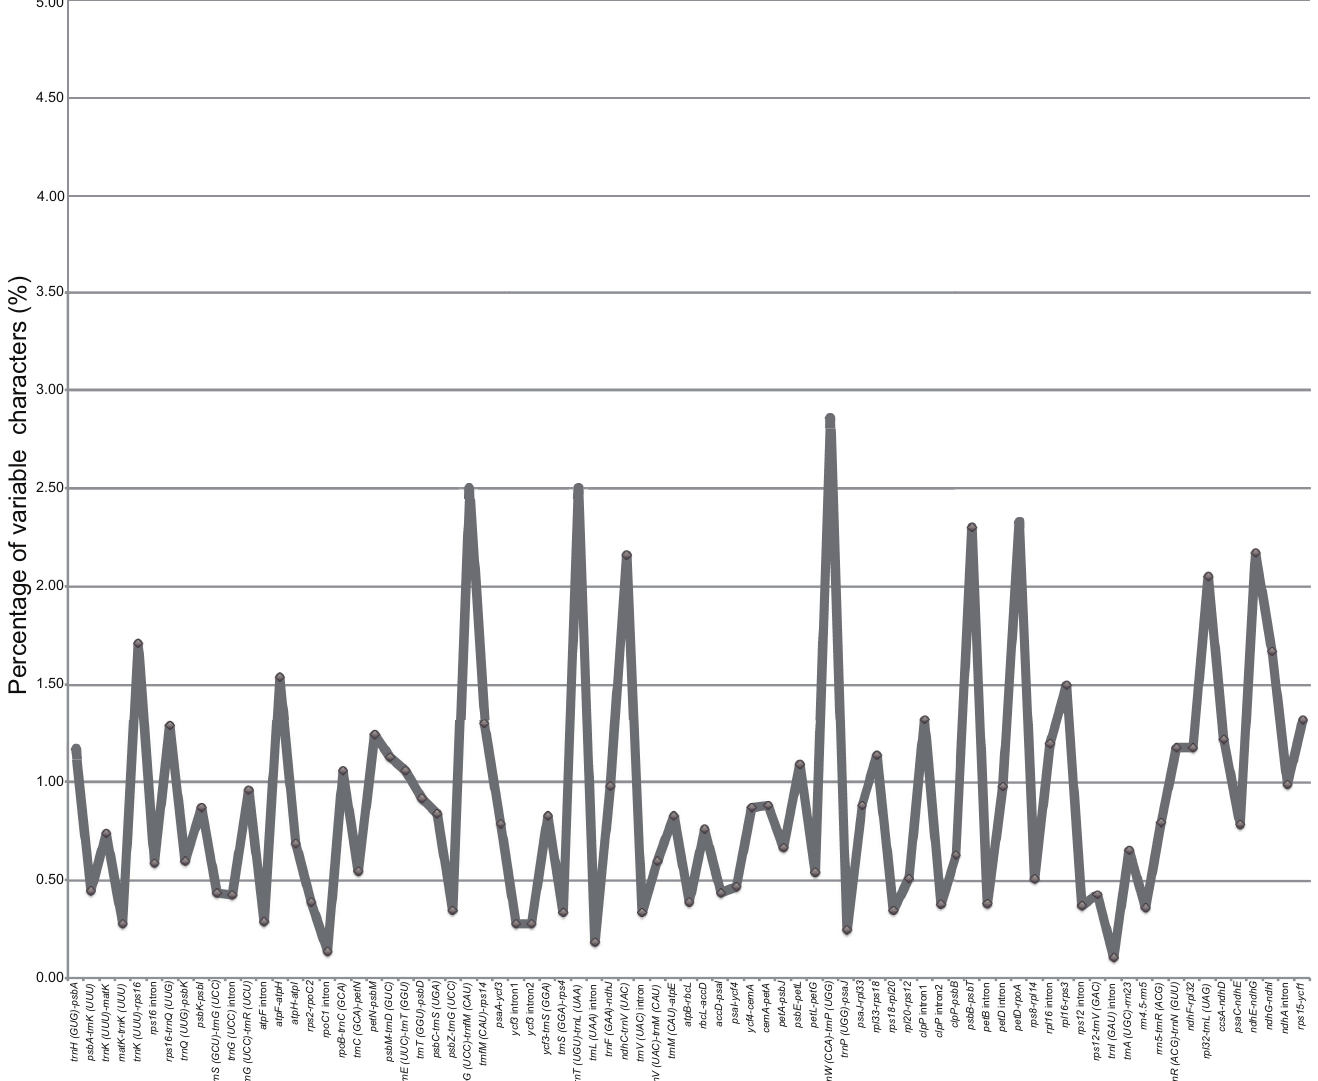
Fig 4. Percentage of variation in 79 variable noncoding regions of the 11 Schima chloroplast genomes. These regionsare oriented accordingto their locationsin the genome.